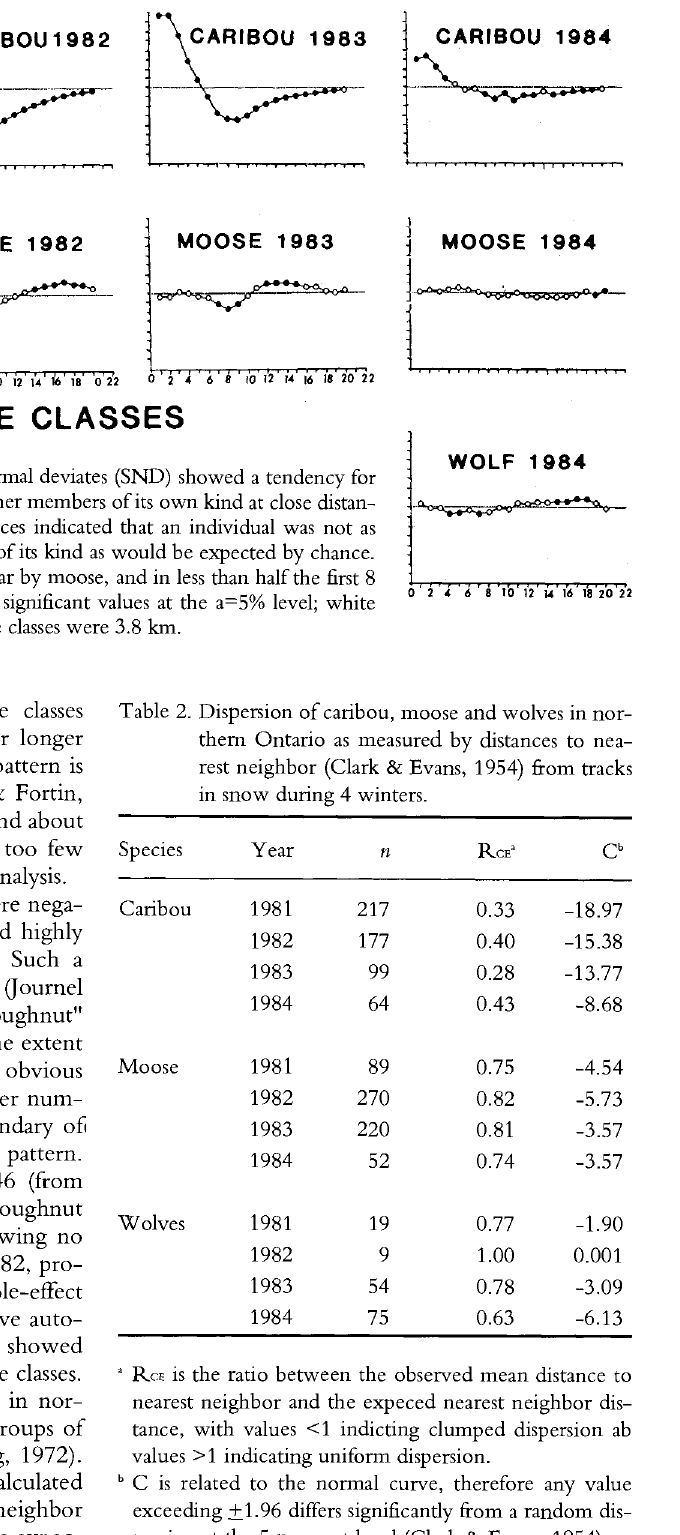
1 RCE is the ratio between the observed mean distance to nearest neighbor and the expeced nearest neighbor dis tance, with values <1 indicting clumped dispersion ab values > 1 indicating uniform dispersion. b C is related to the normal curve, therefore any value exceeding +1.96 differs significantly from a random dis persion at the 5 per cent level (Clark & Evans,